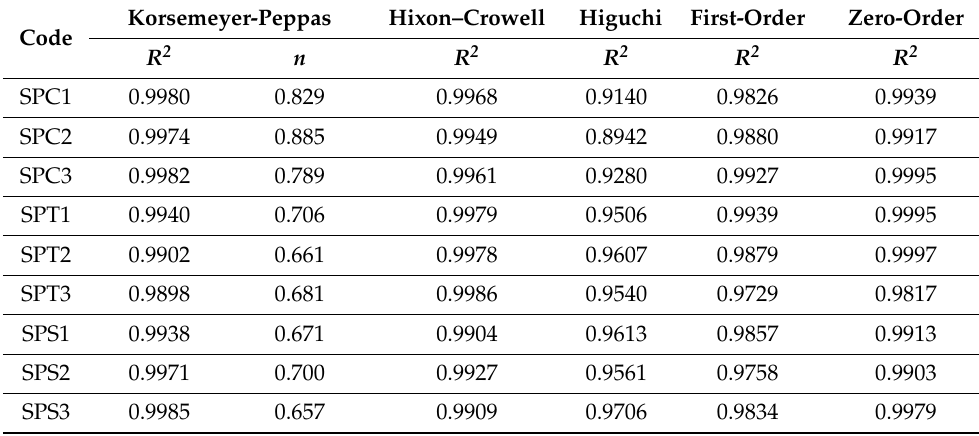
Table 3. Values of kinetics of the pitavastatin